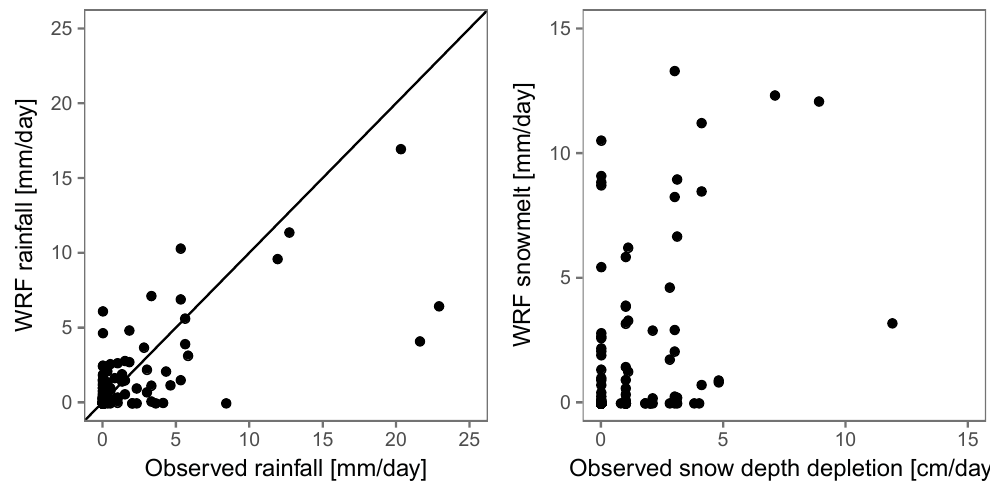
Figure 5. Validation of WRF rainfall ( left panel) and snowmelt ( right panel) forecasts against meteorological observations. The WRF forecasts are aggregated from hourly to daily data in order to match the meteorological records. Black line in the left panel is the 1:1